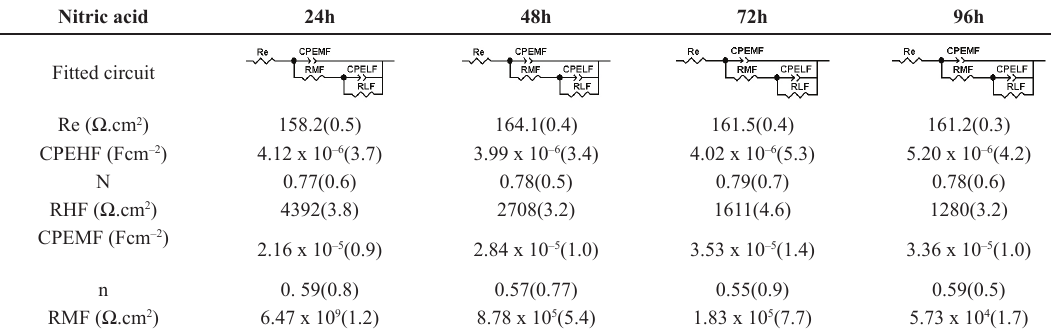
Table 6. Electrical elements fitted values for siloxane-PMMA with nitric acid up to 96 h of immersion in a 0.05M NaCl solution. The error % associated with each parameter value is given in parenthesis. Nitric acid Fitted